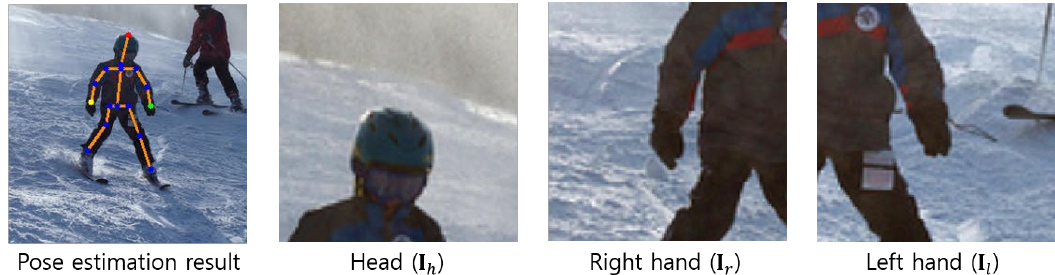
Figure 5. An example of parts localization for the part-image-based feature stream based on the V-COCO dataset [16]. The localized parts are input to the part-image-based feature